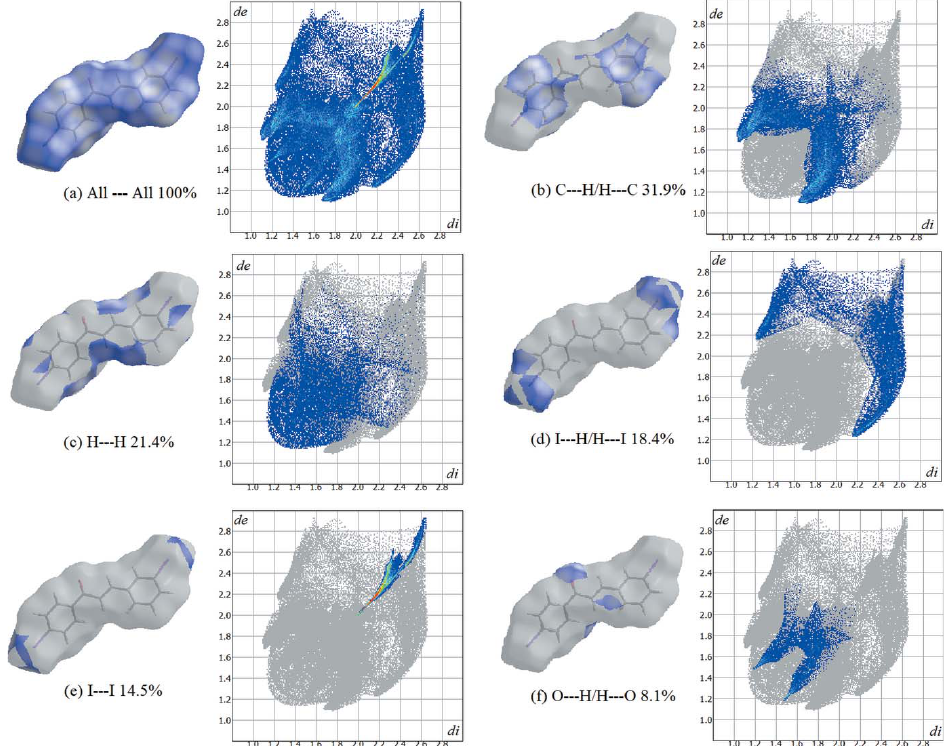
Figure 5 Hirshfeld surfaces and fingerprint plots showing percentage of contacts of ( a ) all interactions, ( b ) C (cid:3)(cid:3)(cid:3) H/H (cid:3)(cid:3)(cid:3) C, ( c ) H (cid:3)(cid:3)(cid:3) H, ( d ) I (cid:3)(cid:3)(cid:3) H/H (cid:3)(cid:3)(cid:3) I, ( e ) I (cid:3)(cid:3)(cid:3) I and ( f ) O (cid:3)(cid:3)(cid:3) H/H (cid:3)(cid:3)(cid:3) O. interactions.